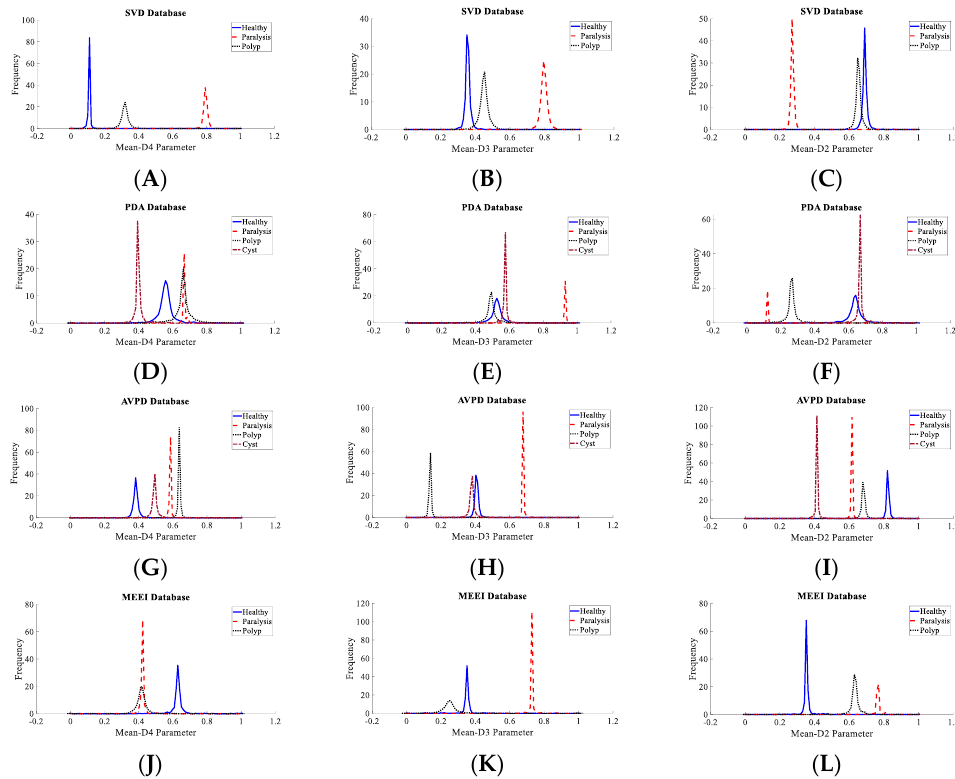
Figure 10. PDF plots of three most common descriptors for multiclass experiments: ( A ) Density plot for Mean-D4 parameter of SVD, ( B ) Density plot for Mean-D3 parameter of SVD, ( C ) Density plot for Mean-D2 parameter of SVD, ( D ) Density plot for Mean-D4 parameter of PdA, ( E ) Density plot for Mean-D3 parameter of PdA, ( F ) Density plot for Mean-D2 parameter of PdA, ( G ) Density plot for Mean-D4 parameter of AVPD, ( H ) Density plot for Mean-D3 parameter of AVPD, ( I ) Density plot for Mean-D2 parameter of AVPD, ( J ) Density plot for Mean-D4 parameter of MEEI, ( K ) Density plot for Mean-D3 parameter of MEEI, ( L ) Density plot for Mean-D2 parameter of MEEI. Table 6. SVM and SGD classifier metrics for three most common descriptors.